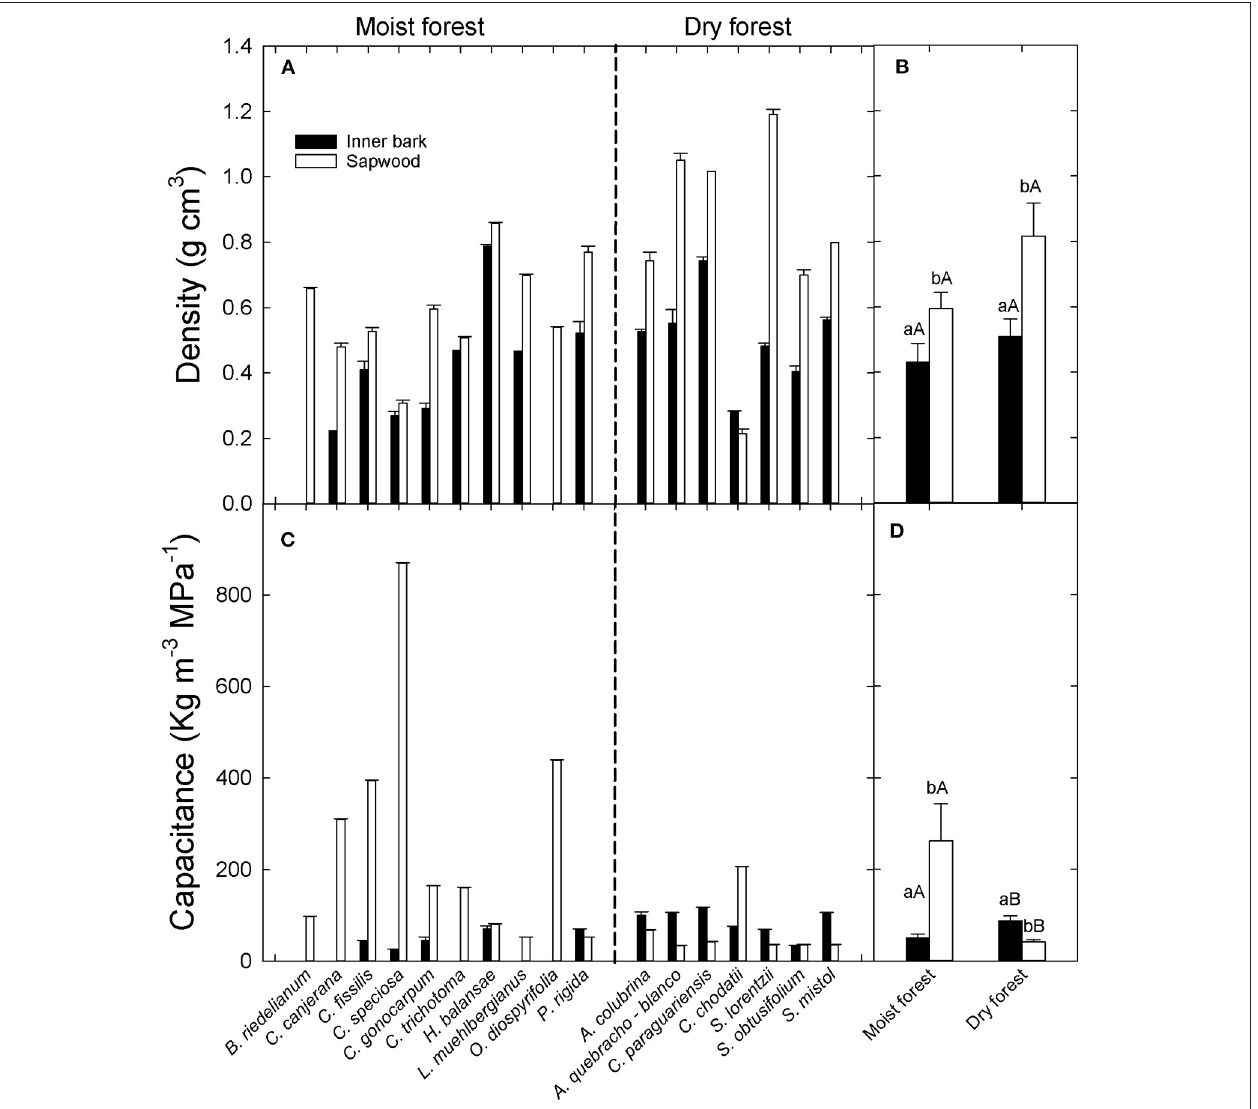
FIGURE 1 | (A) Inner bark and sapwood density per species (A) and per site (B) and inner bark and sapwood capacitance per species (C) and per site (D) in two forests in the extremes of a precipitation gradient in northern Argentina. Different lower cases in (B,D) indicate significant differences between inner bark and sapwood within site. Different upper cases indicate significant differences in inner bark or sapwood between